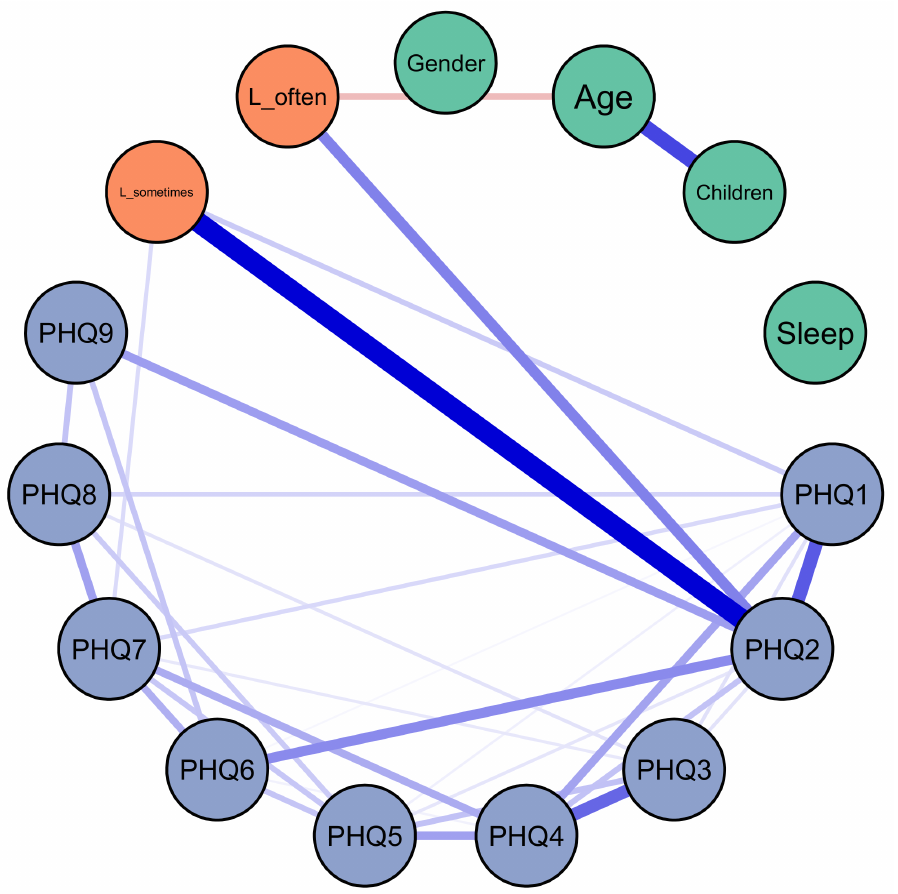
Figure 1. Relationships between PHQ-9 items, demographics and loneliness. Green: demograph- ics; orange: loneliness; blue: PHQ; the edge between L_sometimes and L_often was excluded. L_sometimes = dummy variable encoding loneliness “sometimes” as 1, “never” or “often” as 0; L_often = dummy variable encoding loneliness “often” as 1, “never” or “sometimes” as 0; children = living with children in the same household; sleep = average hours of sleep per night in the previous 7 days; Patient Health Questionnaire (PHQ)-1 = little interest or pleasure in doing things; PHQ-2 = feeling down, depressed, or hopeless; PHQ-3 = trouble falling or staying asleep, or sleeping too much; PHQ-4 = feeling tired or having little energy; PHQ-5 = poor appetite or overeating; PHQ-6 = feeling bad about yourself—or that you are a failure or have let yourself or your family down; PHQ-7 = trouble concentrating on things, such as reading the newspaper or watching television; PHQ-8 = moving or speaking so slowly that other people could have noticed. Or the opposite—being so fidgety or restless that you have been moving around a lot more than usual; PHQ-9 = thoughts that you would be better off dead, or of hurting